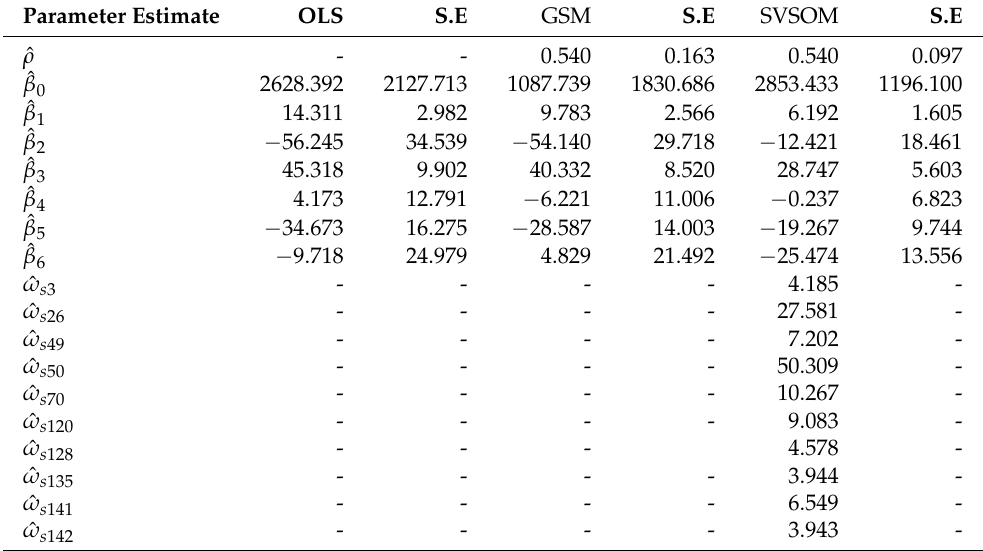
Table 3. The results of the OLS, GSM and SVSOM fits with inflation in variance in the SVSOM. Parameter Estimate